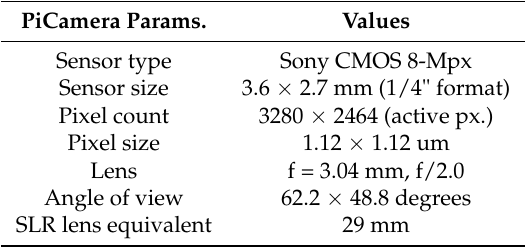
Table 1. PiCamera (v2.1 board) technical intrinsic